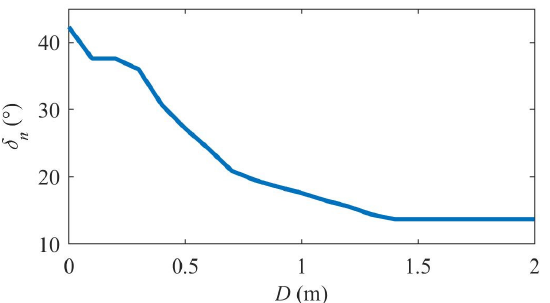
Figure 12. Rise angle δ n course of fuzzy control surface along the D axis at constant displacement angle δ 0 = − 20°.